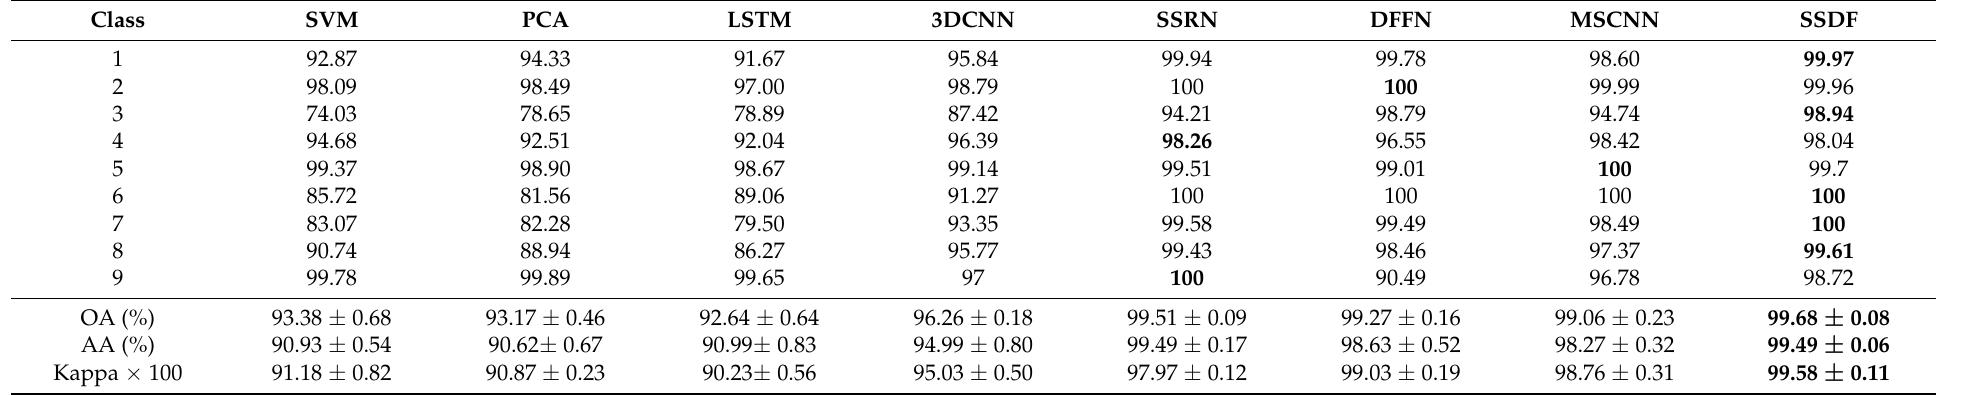
Table 5. The classification results of all methods on the Pavia University dataset with OA, AA, and Kappa data given in the form of mean ± standard